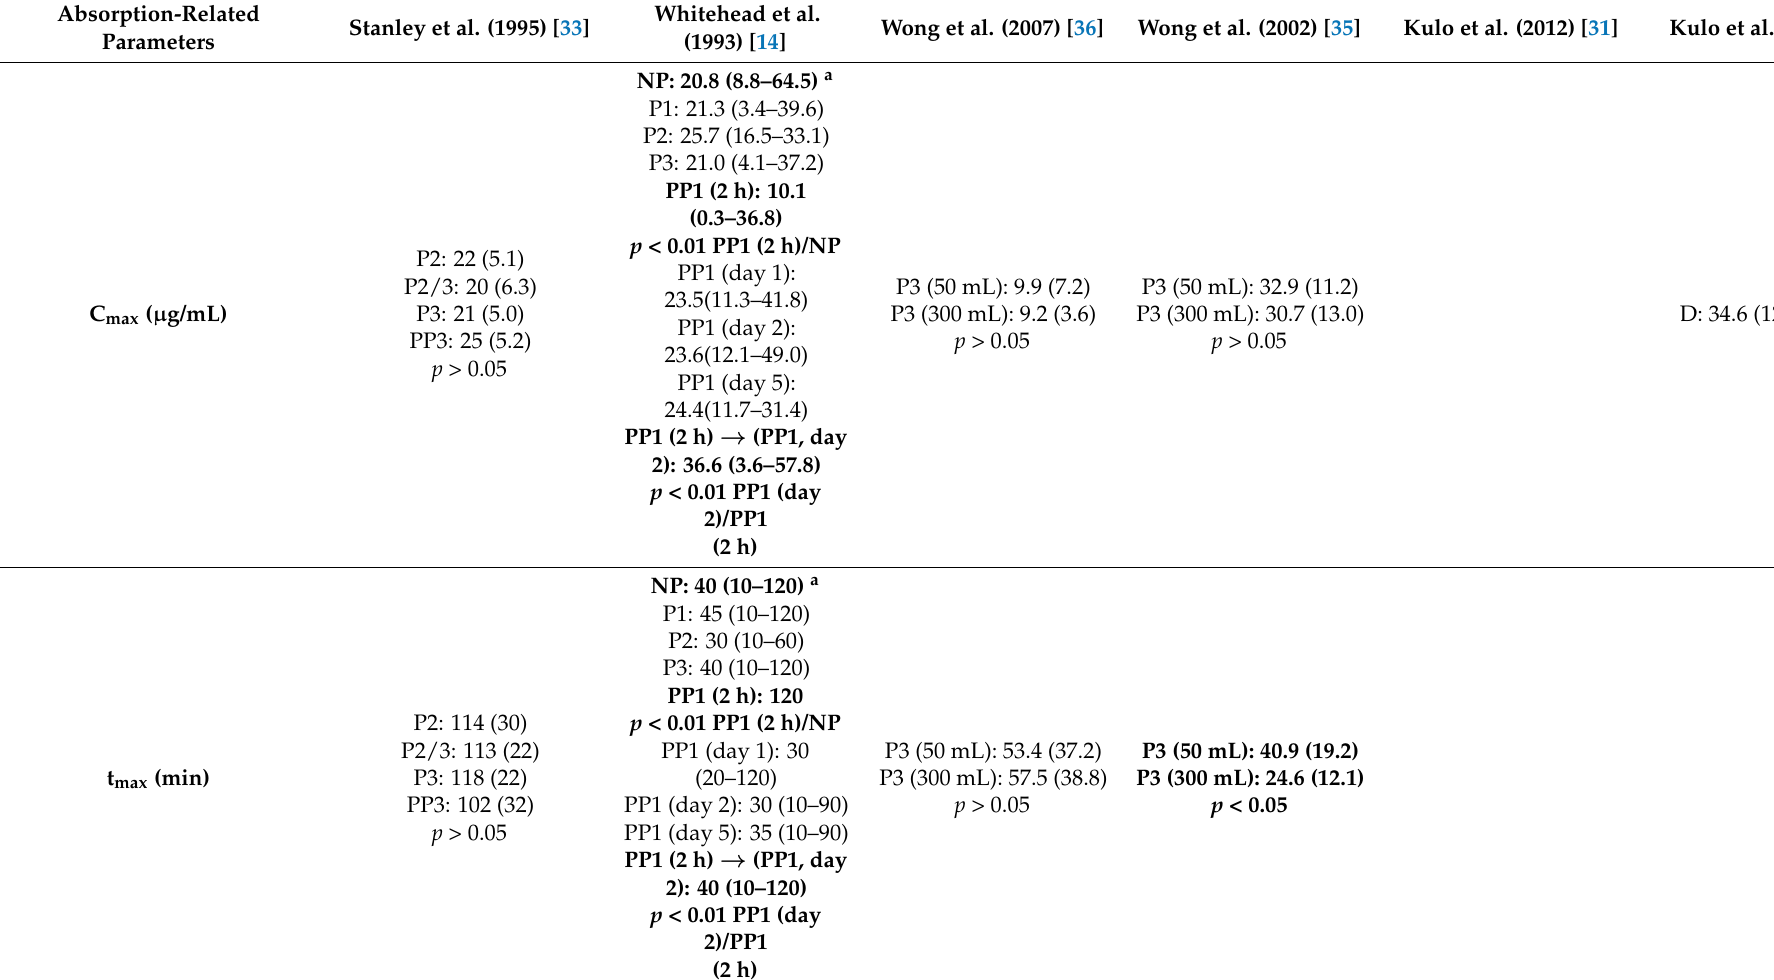
Table 4. Summary of pregnancy-induced changes in the pharmacokinetic parameters, obtained with NCA, of acetaminophen and its metabolites. Studies are presented in alphabetical order by author. Data are given in median [range], mean (SD) unless other use is specified.